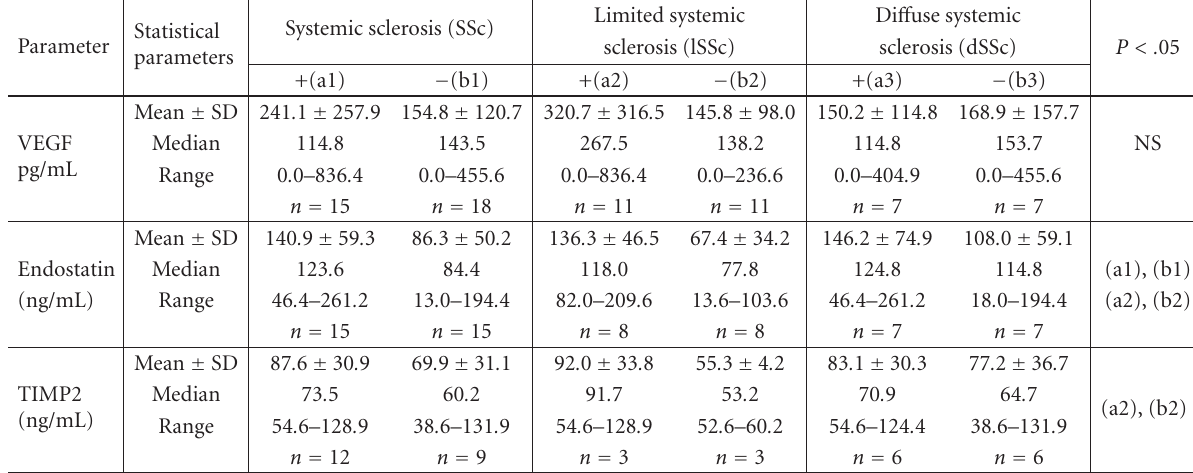
Table 3. Comparison of VEGF, endostatin, and TIMP2 serum levels in systemic sclerosis patients with or without heart involvement. (a1), (a2), and (a3) denote patients with heart involvement; (b1), (b2), and (b3) denote patients without heart involvement; SD is the standard deviation; n is the number of